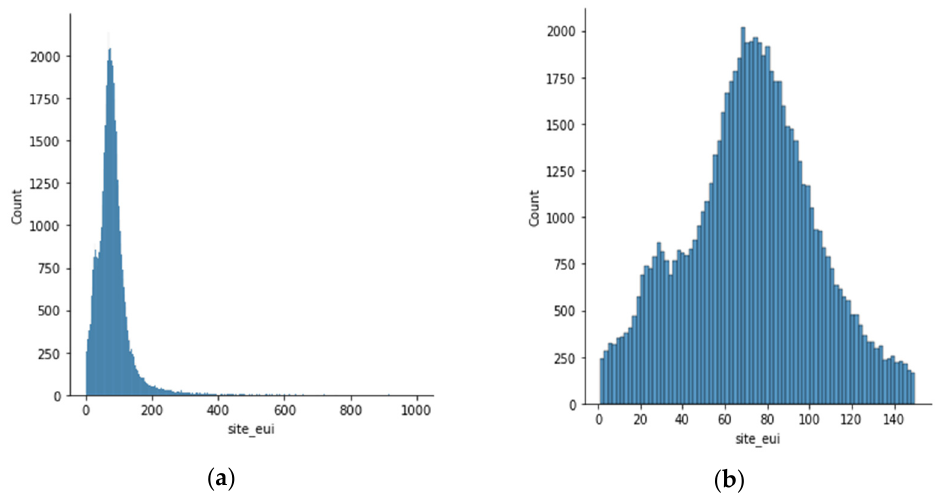
Figure 2. Graphical representation of outlier removal in the dataset. ( a ) Before skewness removal. ( b ) After skewness removal.